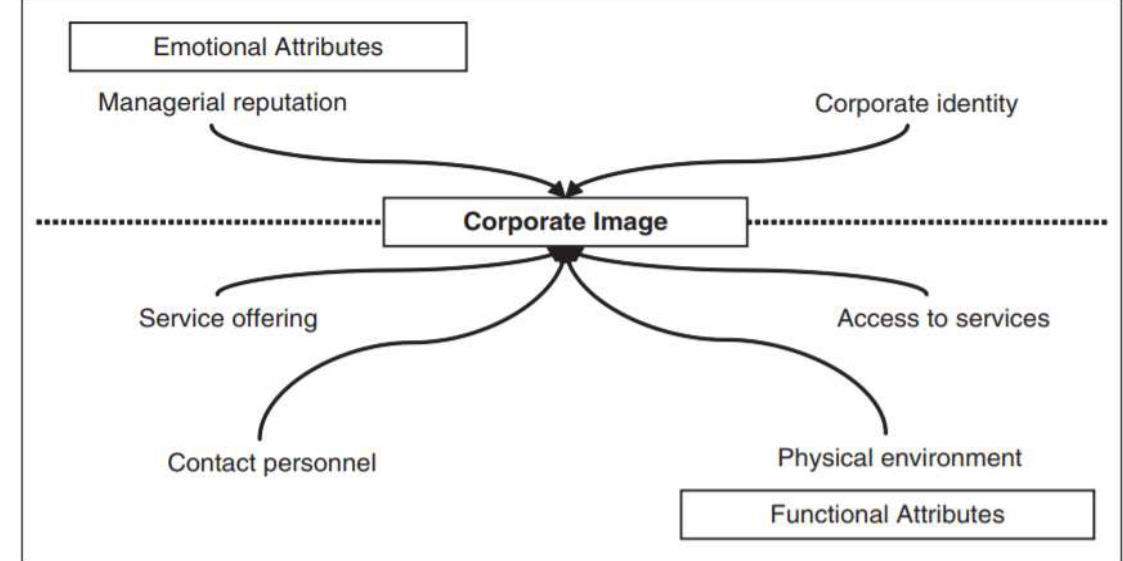
Fig. 1. The corporate image model by LeBlanc and Nguyen Source: LeBlanc and Nguyen (1996).